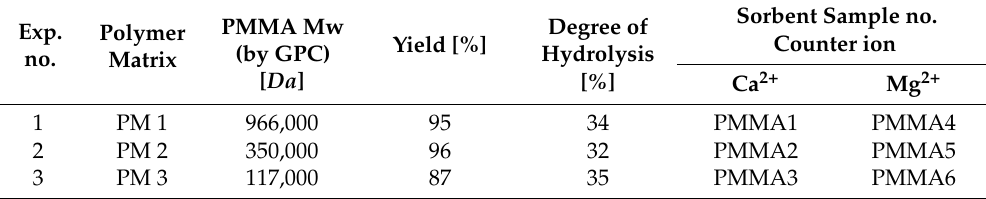
Table 1. PMMA hydrolysis-crosslinking reaction data.